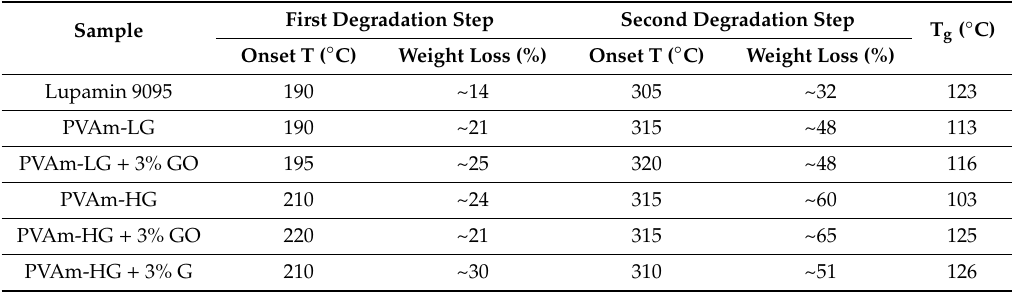
Table 1. Onset degradation temperatures, weight loss (from TGA) and glass transition temperature (T g ) (from DSC) of commercial Lupamin 9095 and purified PVAm with and without G and